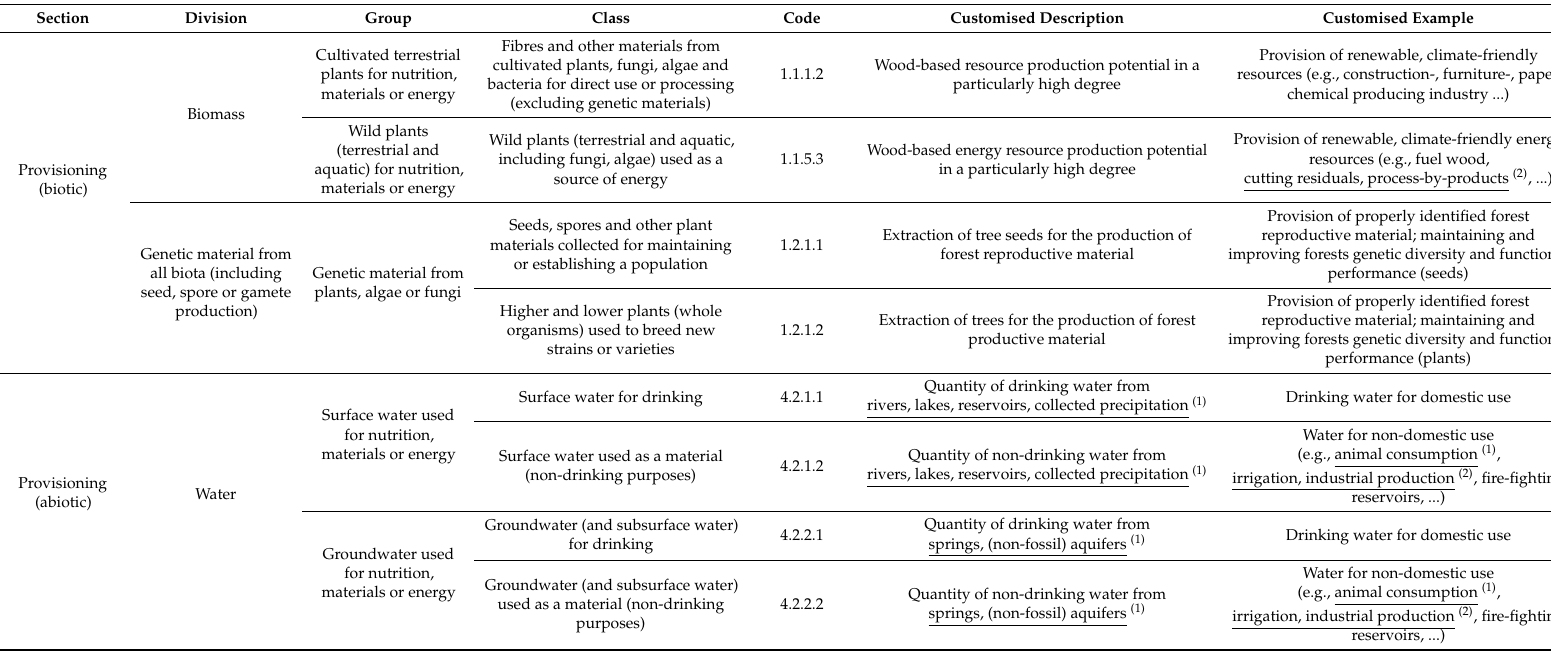
Table 3. Customised CICES Framework for provisioning services (biotic and abiotic). Source: own representation. Underlined text is inspired by (1) [43] and (2) [30].